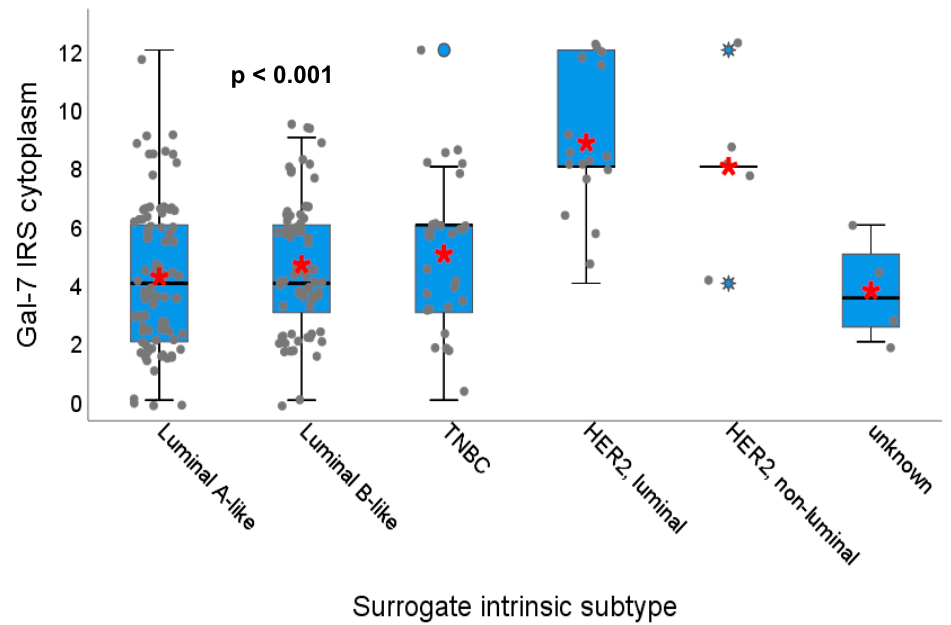
Figure 4. Association of Gal-7 expression with different surrogate intrinsic subtype. Boxplot of the median IRS of Gal-7 staining in the cytoplasm dependent on the surrogate intrinsic subtype of the tumor is shown. HER2-positive, both luminal and non-luminal tumors show a significantly higher Gal-7 expression in the cytoplasm compared to the other subtypes. Red asterisks indicate means. Please note that individual datapoints have been jittered to avoid overlap.